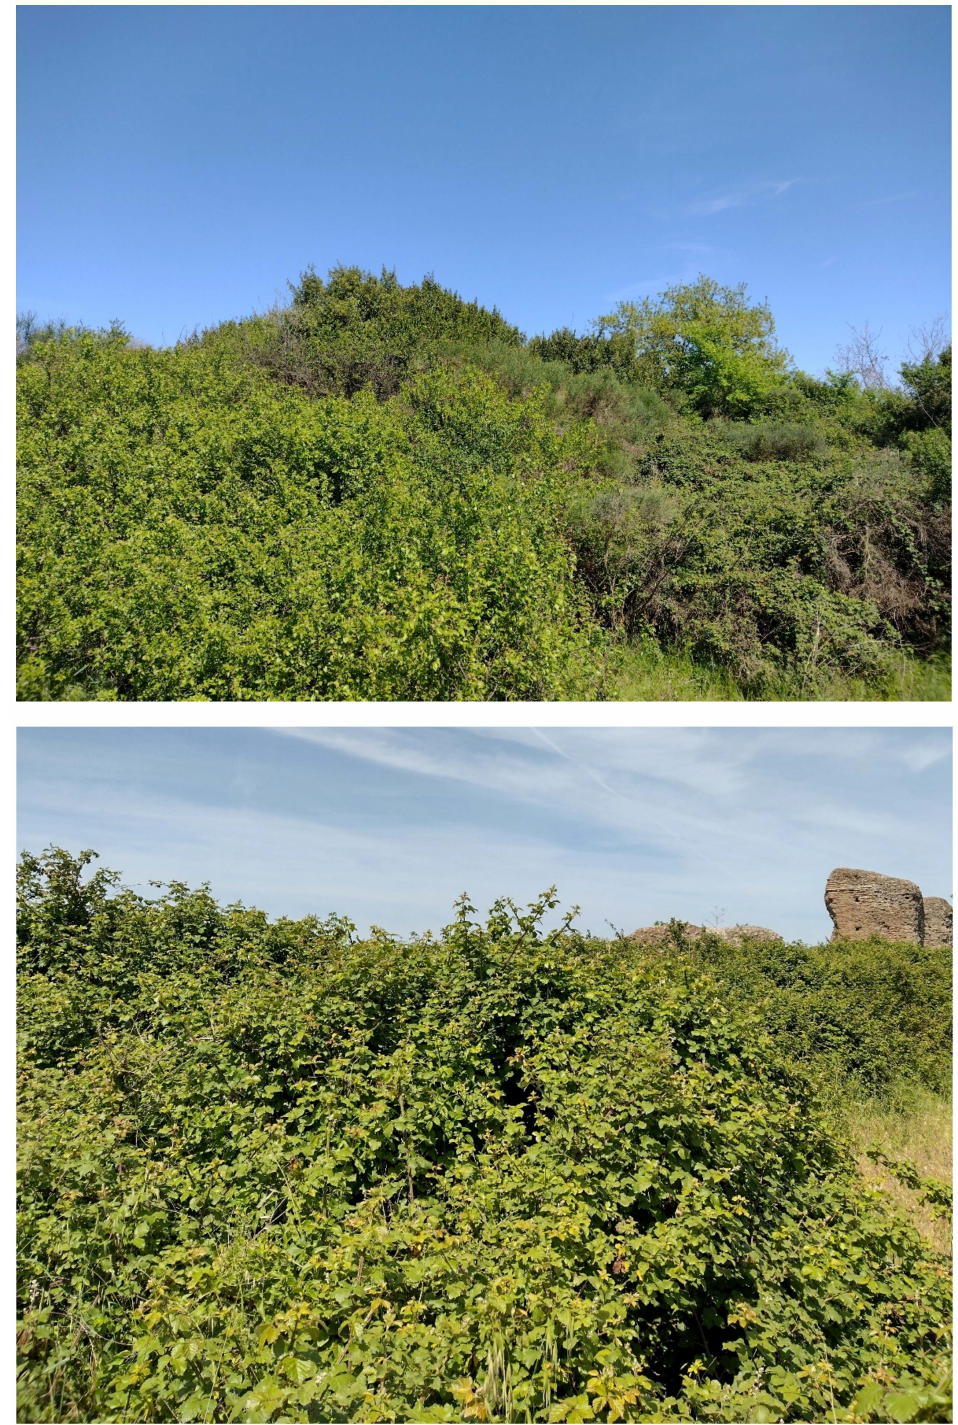
Figure 18. Scrub vegetation of the nemoral zone (Crataego-Prunetea): mixed scrub, locality Caffarella (top photo); monophytic communities with Rubus ulmifolius , locality Acquedotti (bottom